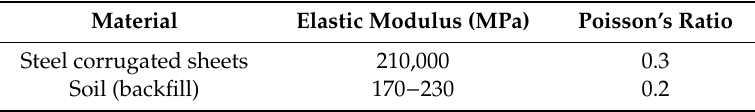
Table 2. Yielding of steel rafter in all the considered local